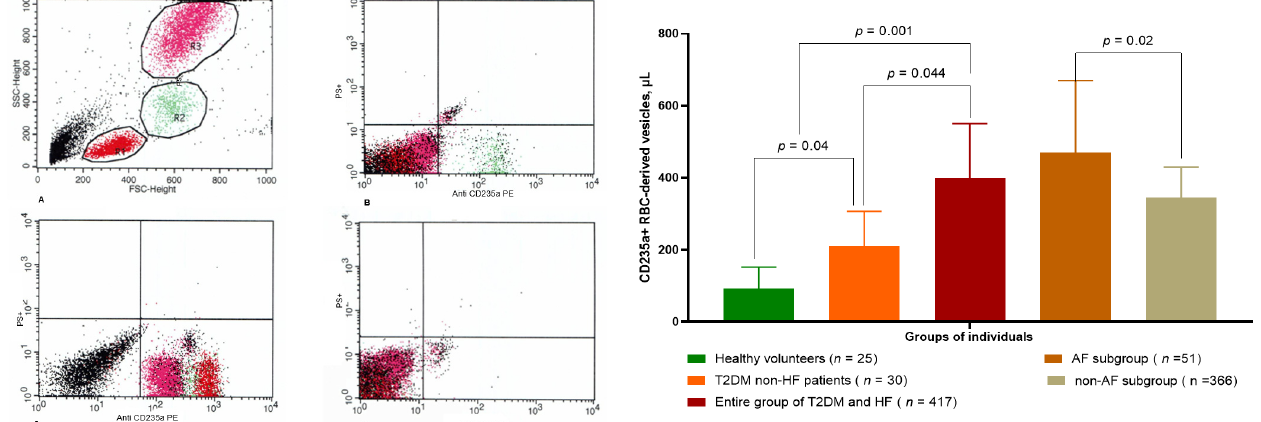
Figure 1. Amount of circulating CD235a+ PS+ RBC-derived vesicles: ( Left panel ) depicts results of flow cytometry measure of PS+ CD235a+ RBS-derived vesicles; Distinguishing populations of RBC-derived vesicles were determined at the first step of gaiting depending on their size (<0.5 µm) using forward scatter and side scatter dot plot ( A ). Next, CD235a+ RBC- derived vesicles and PS+ RBC- derived vesicles were determined as double-positive events for labels indicated as CD235a+ and PS+ in T2DM non-HF ( B ), T2DM patients with HF ( C ) when compared with healthy volunteers ( D ). ( Right panel ) illustrate comparable proportion of circulating amount of CD235a+ PS+ RBC-derived vesicles in different cohorts of eligible individuals. Abbreviations: T2DM, type 2 diabetes mellitus; HF, heart failure; AF, atrial fibrillation, RBC, red blood cells; PS, phosphatidylserine.